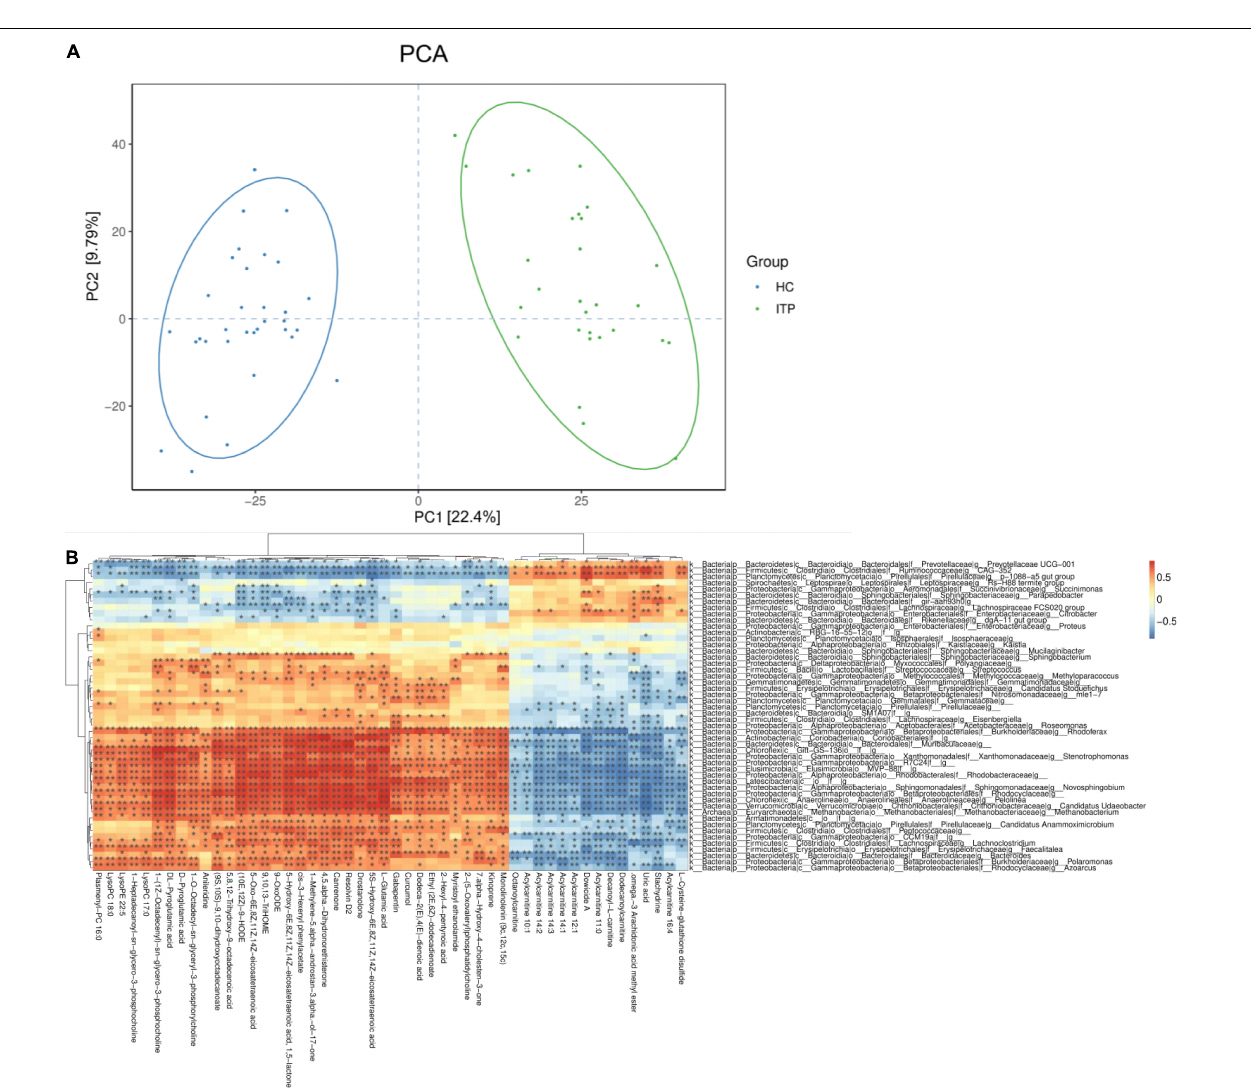
Frontiers in Medicine |